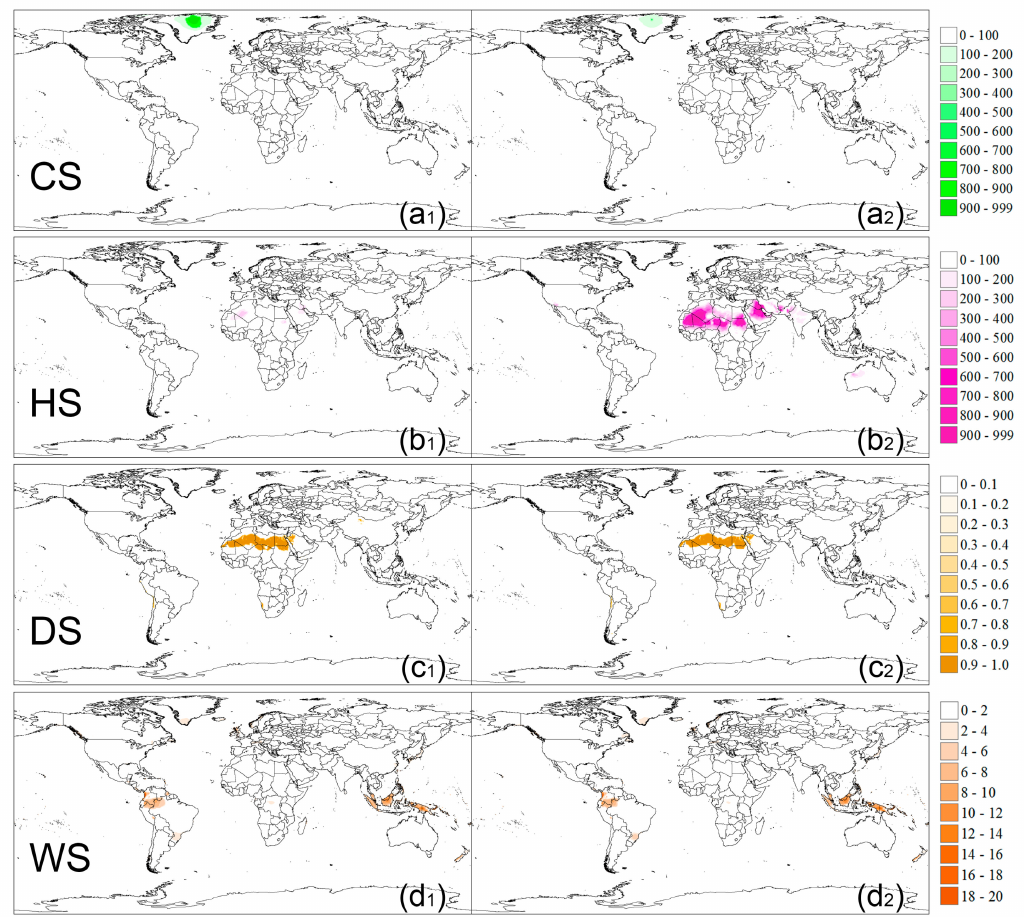
Figure 8. Global map of monthly stress indices for C. vesuviana . ( a ) Map of monthly cold stress (CS), ( b ) map of monthly heat stress (HS), ( c ) map of monthly dry stress (DS), and ( d ) map of monthly wet stress (WS). Subscript (1) indicates historical climatic conditions and subscript (2) indicates future climatic conditions. Depth of color indicates the weight of each value: the darker the color, the larger the value.